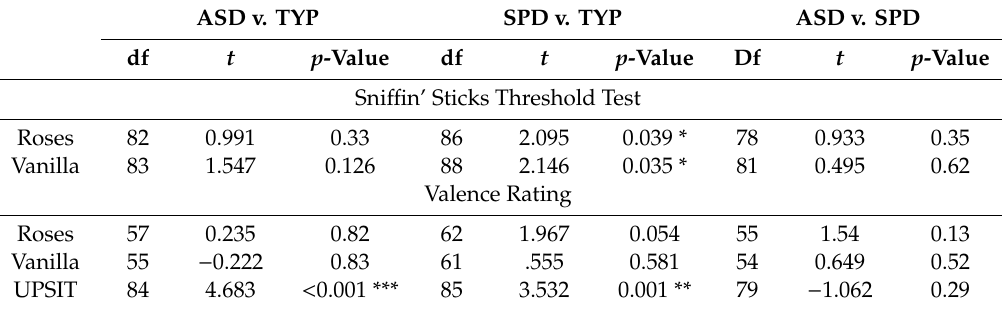
Table 3. Olfactory function between